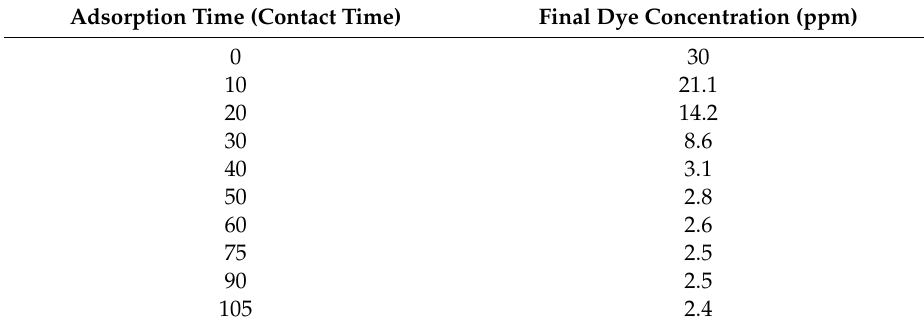
Table 3. Determination of equilibrium time for methylene blue (MB) dye adsorption onto activated